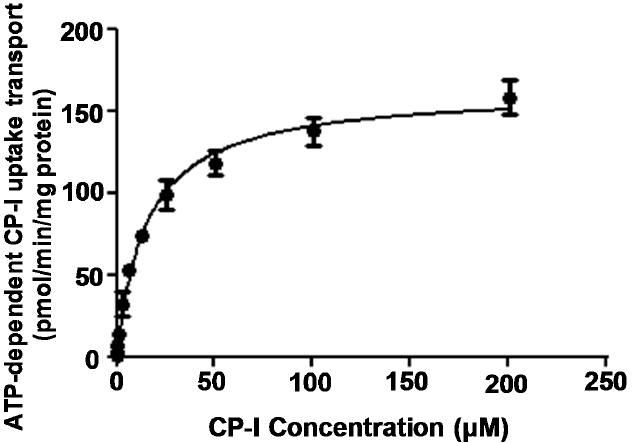
Figure 1. Concentration-dependent uptake transport of coproporphyrin-I (CP-I) in rat multidrug resistance-associated protein 2 (Mrp2) membrane vesicles . Rat Mrp2 membrane vesicles were